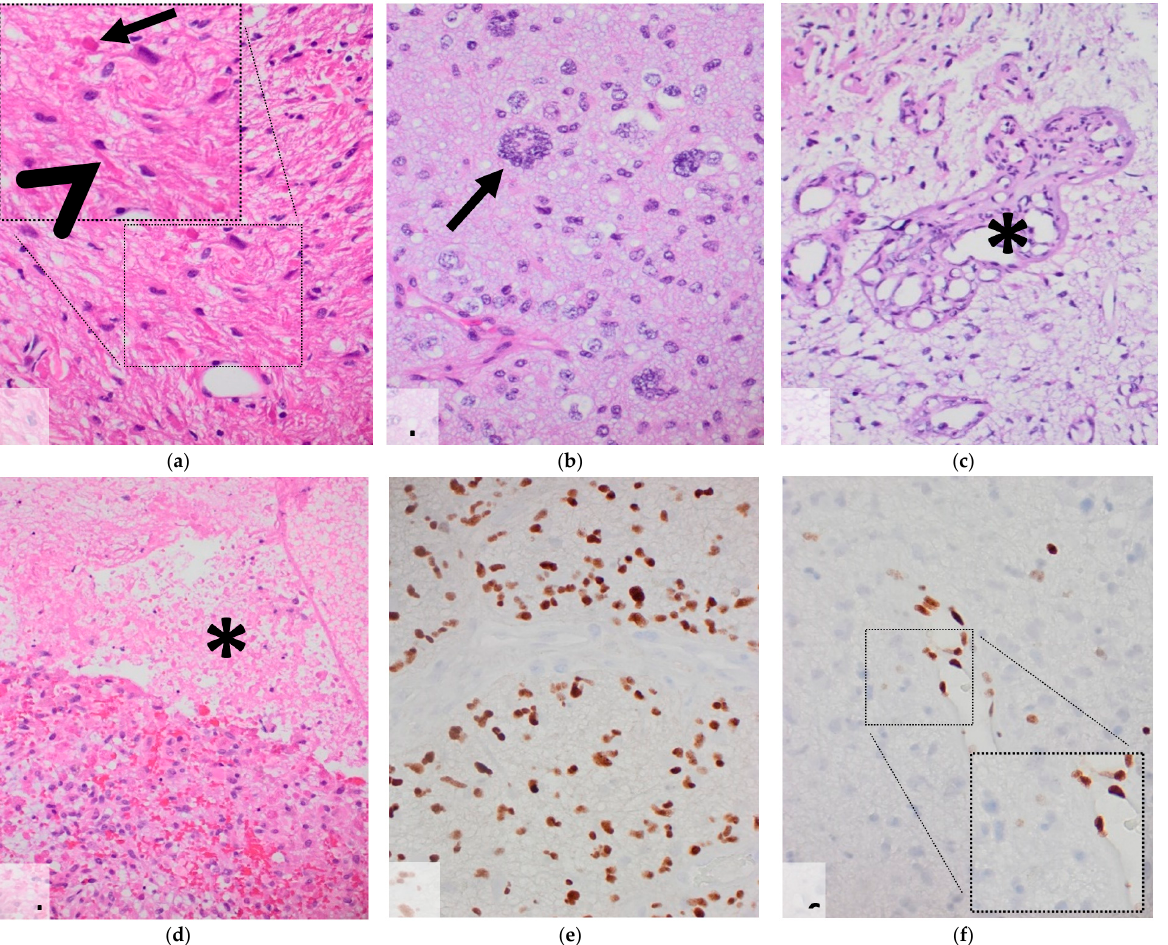
Figure 1. Microscopic pattern of diffuse midline gliomas WHO grade IV H3 K27M-mutated. ( a ) H&E—piloid-like astrocytic tumor cells with Rosenthal fibers (arrow head) and eosinophilic protein droplets (arrow); ( b ) H&E—multinucleated large malignant cells (arrow); ( c ) H&E—multiluminal microvascular proliferates (*); ( d ) H&E—geographic necrosis (*); ( e ) H3 K27M immunohistochem- istry—tumor cells expressing mutated H3 K27M protein with negative endothelial cells; ( f ) H3 K27me3 immunohistochemistry—tumor cells showing loss of expression of trimethylated H3 K27 histone protein with positive endothelial cells.